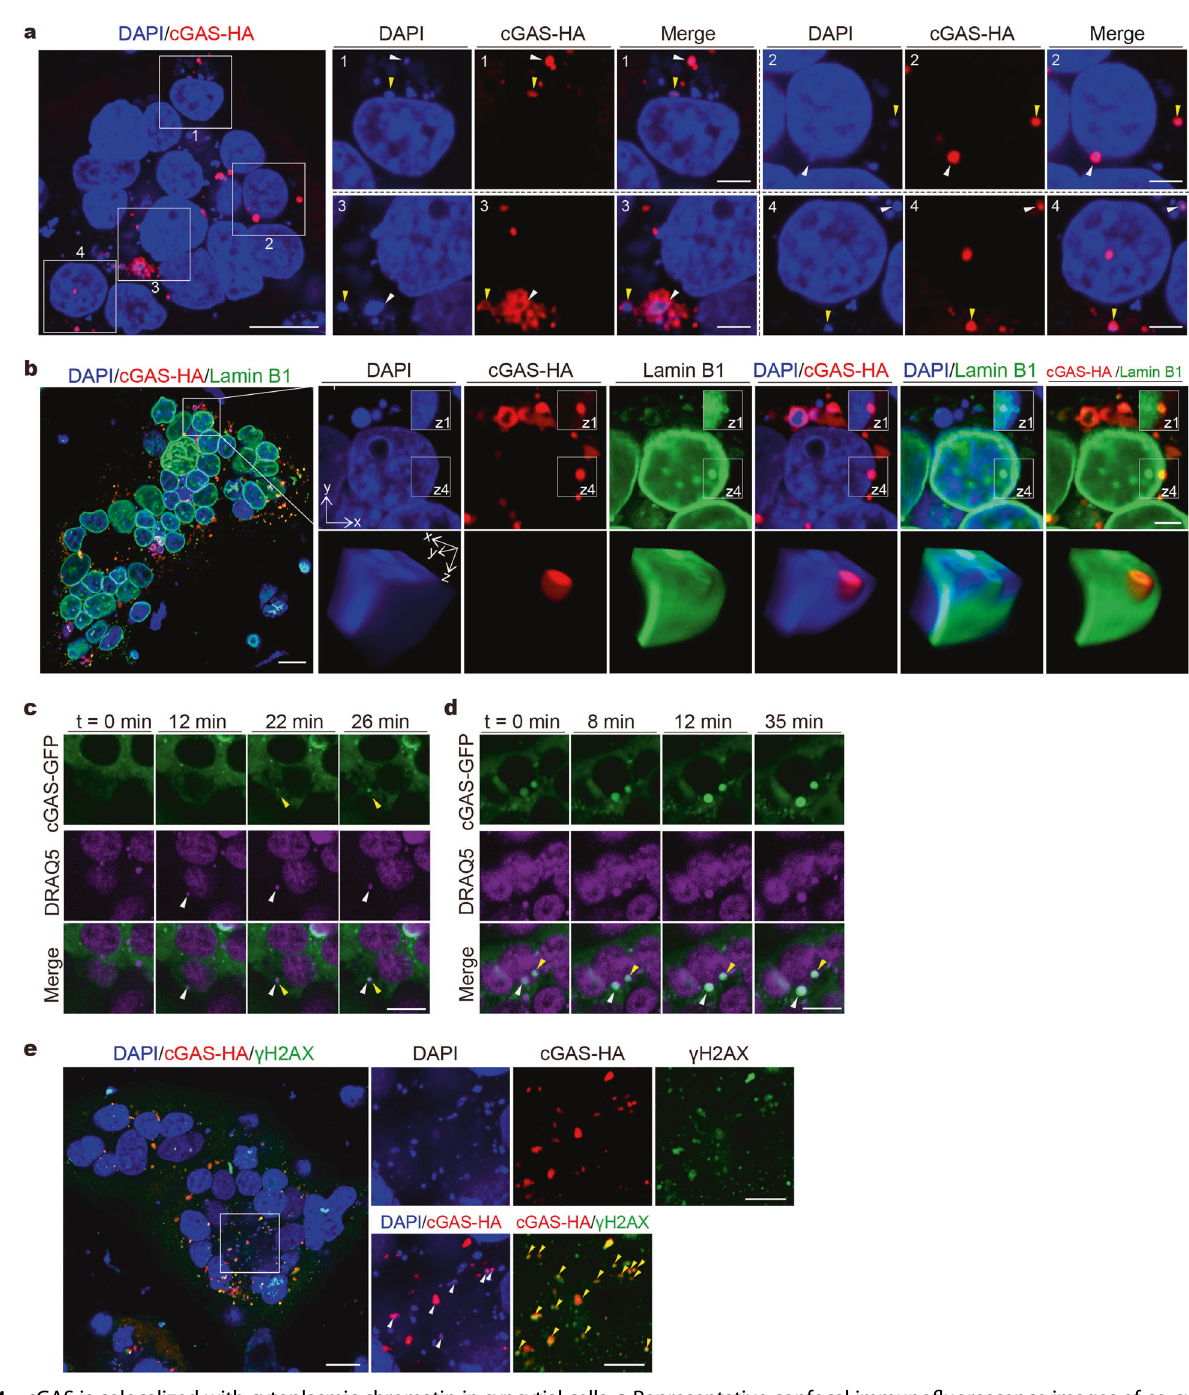
Fig. 4 cGAS is colocalized with cytoplasmic chromatin in syncytial cells. a Representative confocal immuno fl uorescence images of co-cultured cells stained for DNA and cGAS-HA. HEK293T cells transfected with plasmids expressing spike (HEK293T(S)) were co-cultured with cGAS-null HeLa-ACE2 cells transfected with cGAS-HA. After 8 h, cells were stained with DAPI (blue) and anti-HA (red) antibody as indicated. Triangles indicate colocalization of cGAS with cytosolic chromatin. b Representative confocal immuno fl uorescence images of co-cultured cells stained for DNA, cGAS-HA, and Lamin B1. Co-culture experiments were performed as described in a . Cells were stained with DAPI (blue), anti-HA (red), and anti-Lamin B1 (green) antibodies. Three-dimensional reconstructed images based on z-stack images were displayed as volume view. c , d Extracted frames from live-cell imaging of co-cultured cells using confocal microscopy. HEK293T(S) cells transfected with plasmids expressing cGAS-GFP were co-cultured with cGAS-null HeLa-ACE2 cells transfected with plasmids expressing cGAS-GFP. After 1 h, cells were stained with DRAQ5 (purple) for visualizing DNA and subjected to live-cell imaging. e Co-culture experiments were performed as described in a . Cells were stained with DAPI (blue), anti-HA (red) antibody, and anti- γ H2AX (green) antibody. Scale bars, 20 μ m or 5 μ m (inset)